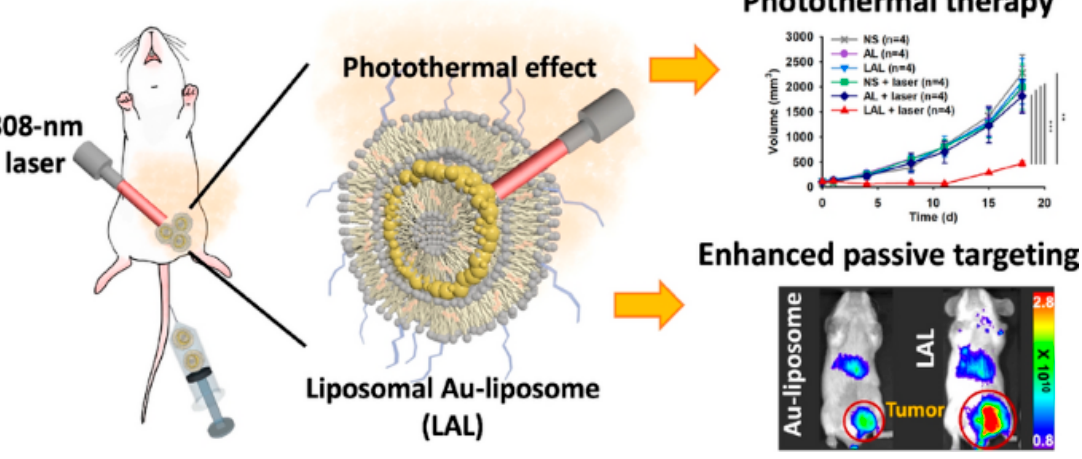
Figure 5. Theranostic dual-layered Au-liposome shown schematically for efficient BC targeting and photothermal treatment, reprinted from [177] .